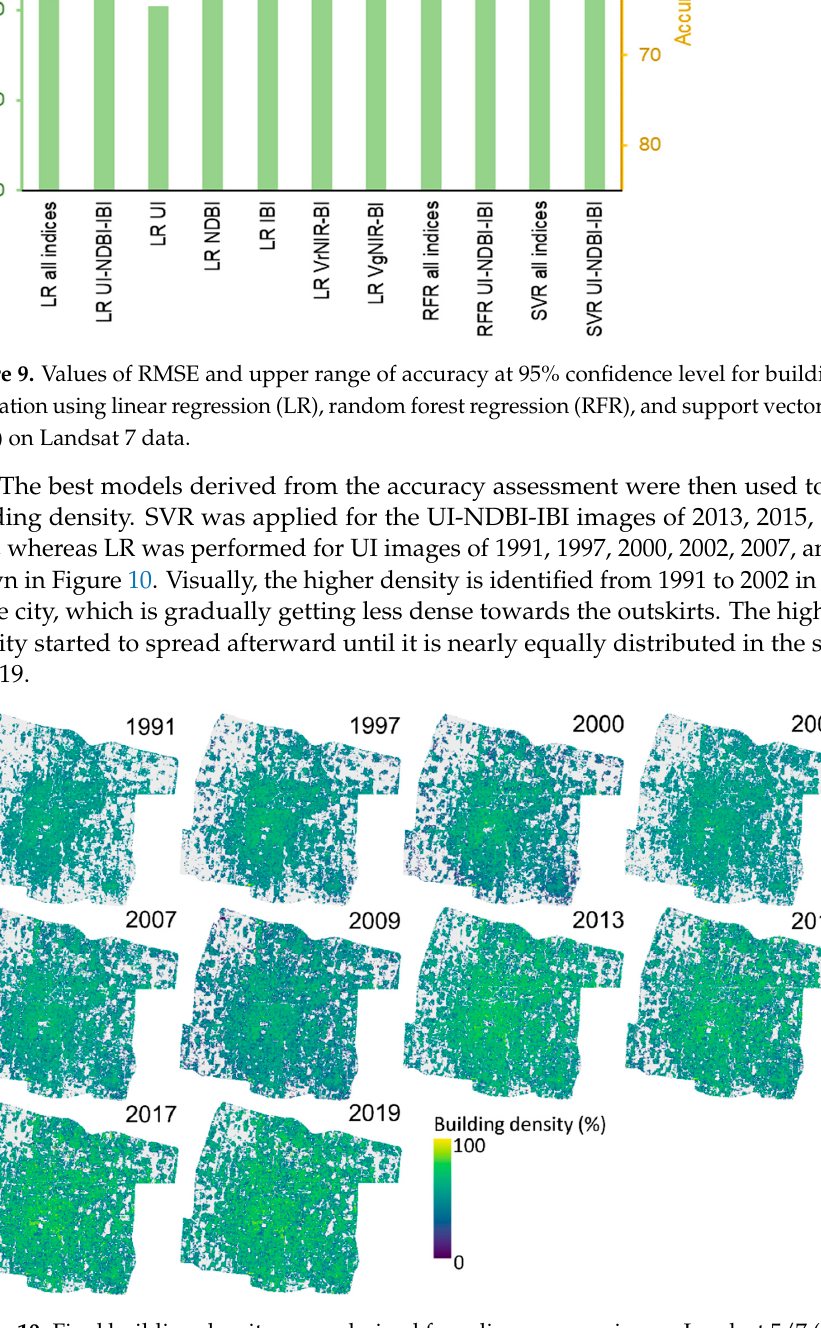
Figure 10. Final building density maps derived from linear regression on Landsat 5/7 (1991–2009) and support vector machine on Landsat 8 images (2013–2019). and support vector machine on Landsat 8 images